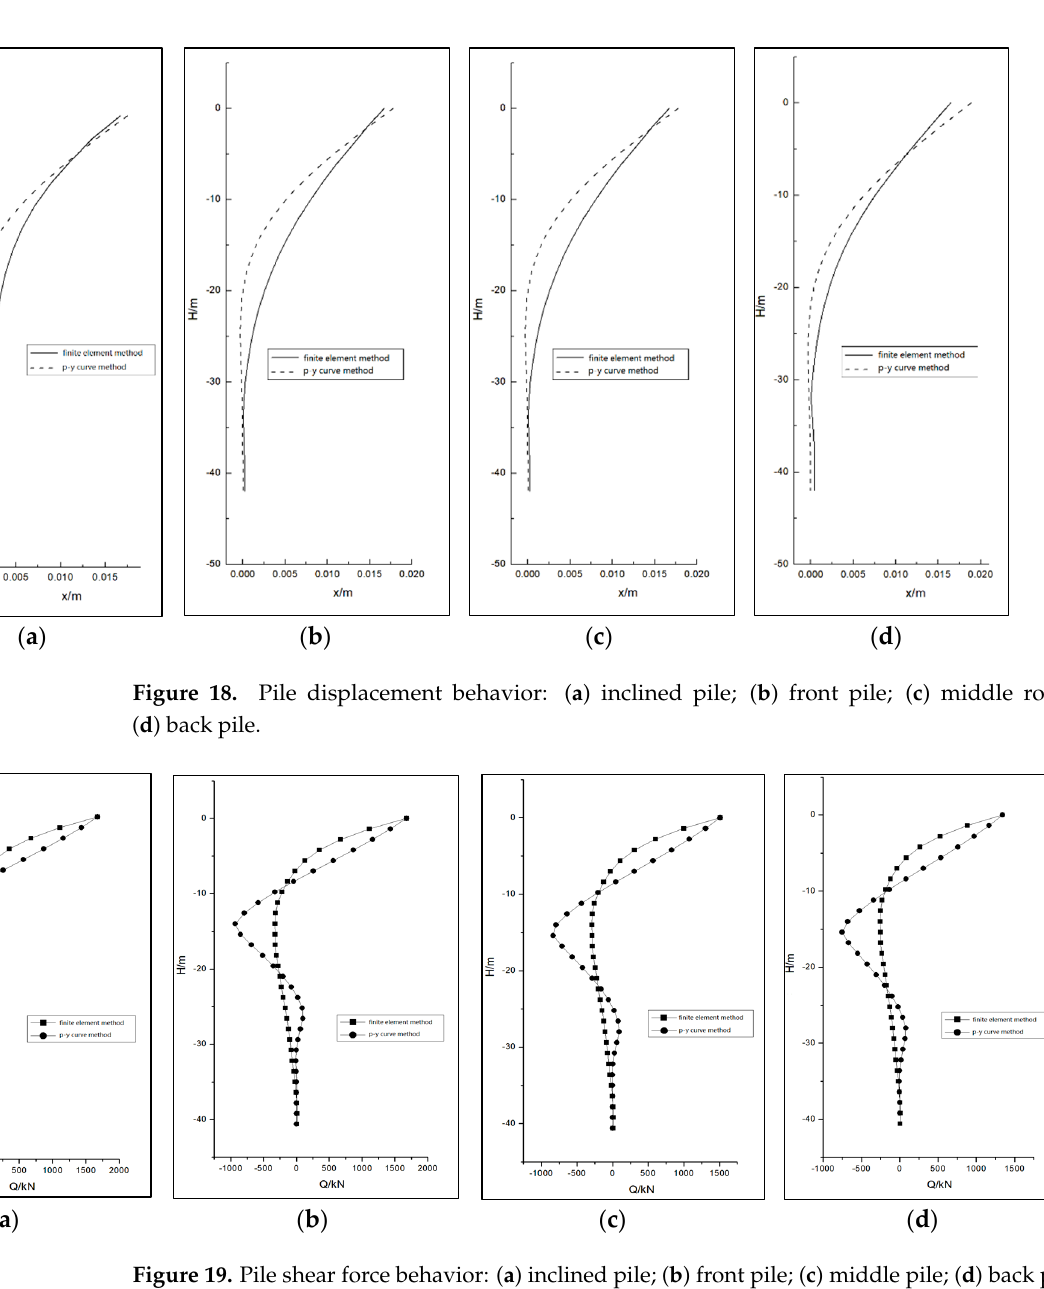
Figure 20. Pile bending moment behavior: ( a ) inclined pile; ( b ) front pile; ( c ) middle pile; ( d ) back pile.